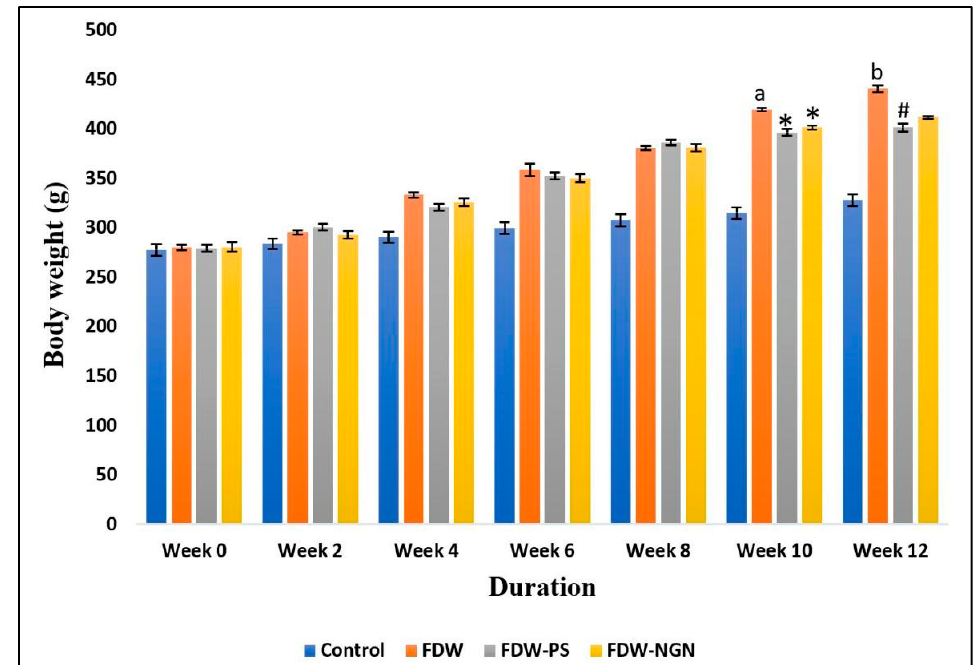
Figure 1. Body weight differences of all groups over 12 weeks. Values are mean ± SD and n = 8 for each group. Superscript letters indicate significantly different. a p < 0.05 compared to the control group at week 10. b p < 0.05 compared to the control group at week 12. * p < 0.05 compared to FDW at week 10. # p < 0.05 compared to FDW and FDW-NGN at week 12. FDW: Olive oil + 20% fructose; FDW-PS: PS + 20% fructose; FDW-NGN: Naringin + 20% fructose.